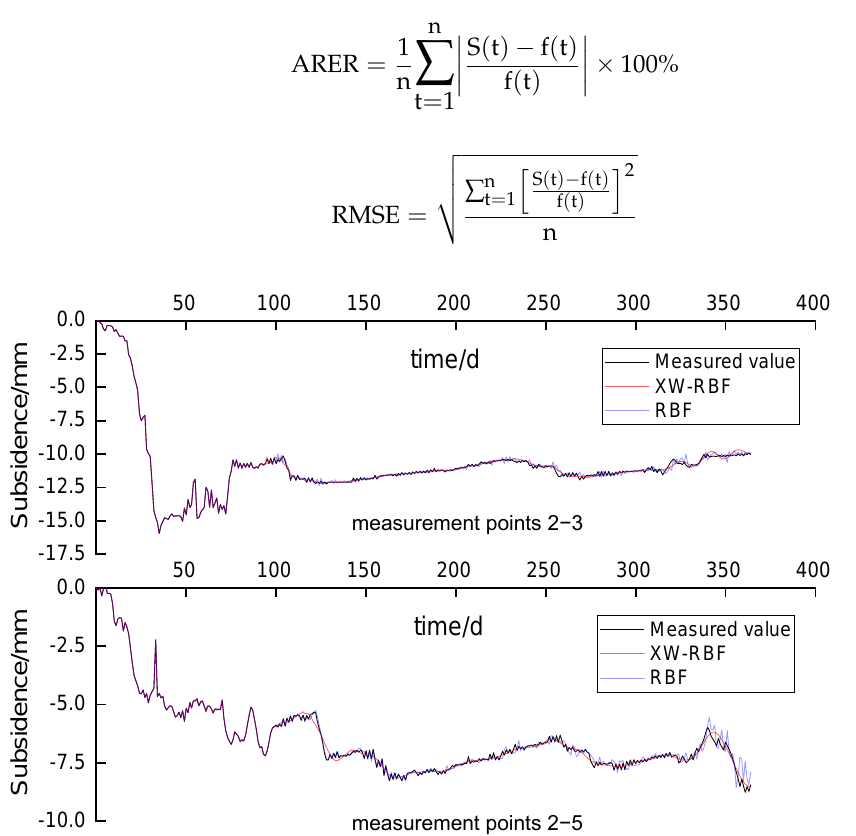
Figure 9. Comparison between the measured and new predicted values of surface subsidence at measuring points 2 − 3 and points 2 − 5.